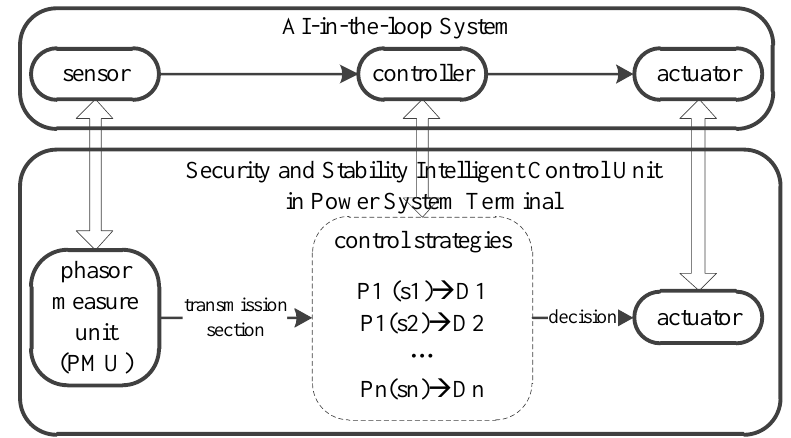
Figure 4. Security and stability intelligent control unit in power system